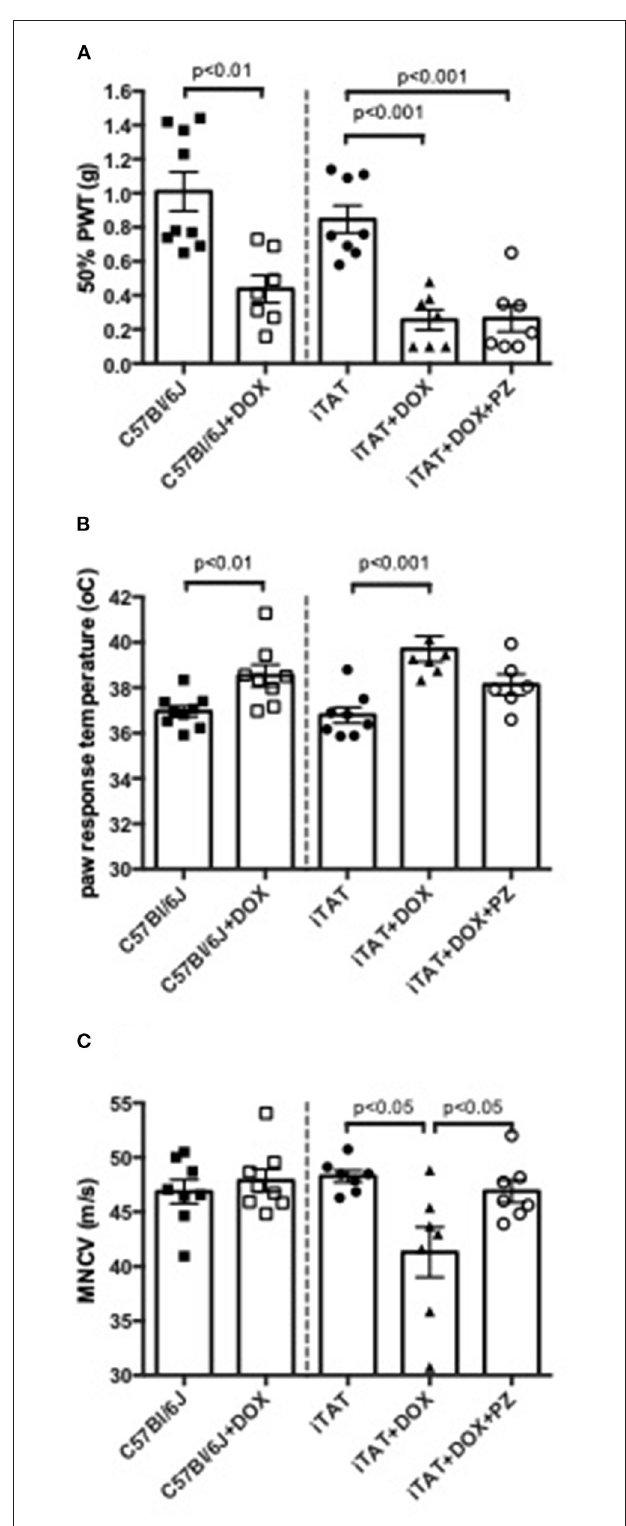
FIGURE 2 | Stimulus-evoked behavior and nerve electrophysiology. (A) Paw response to von Frey filaments, (B) temperature of paw withdrawal